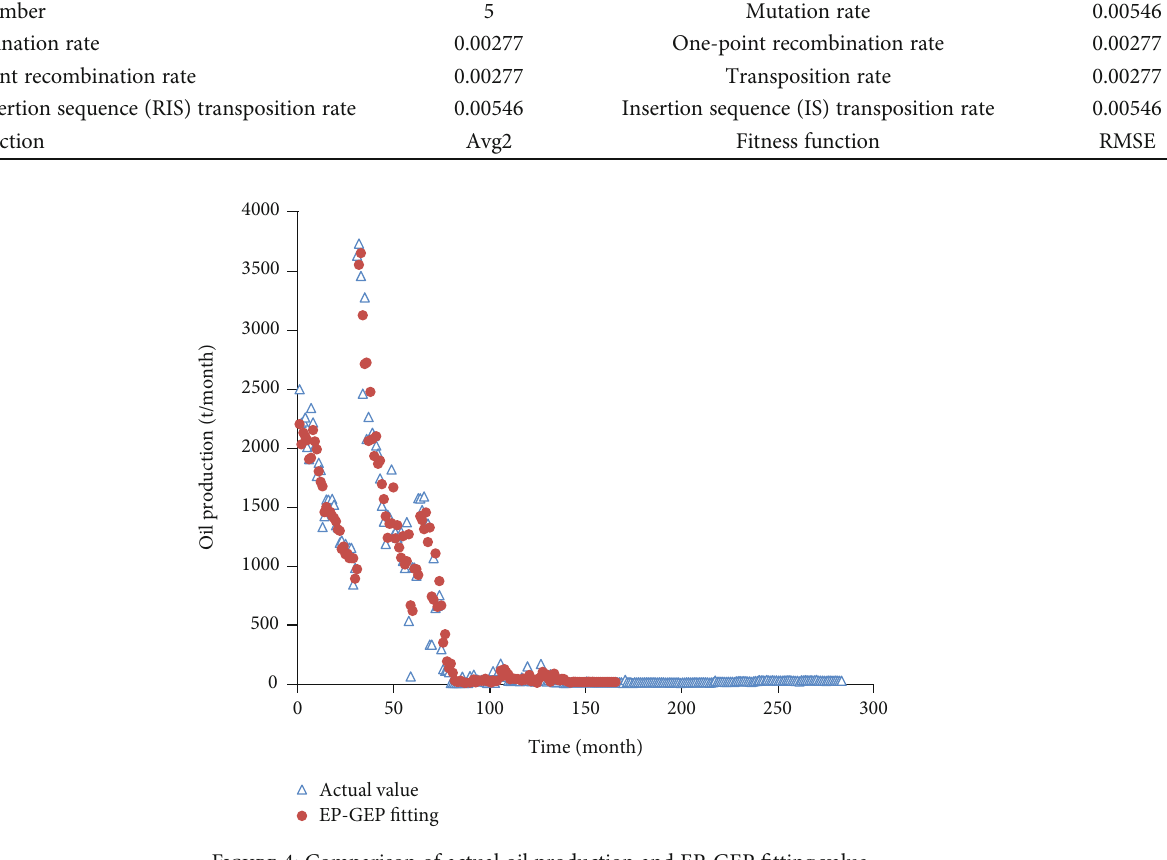
Figure 4: Comparison of actual oil production and EP-GEP fi tting value.